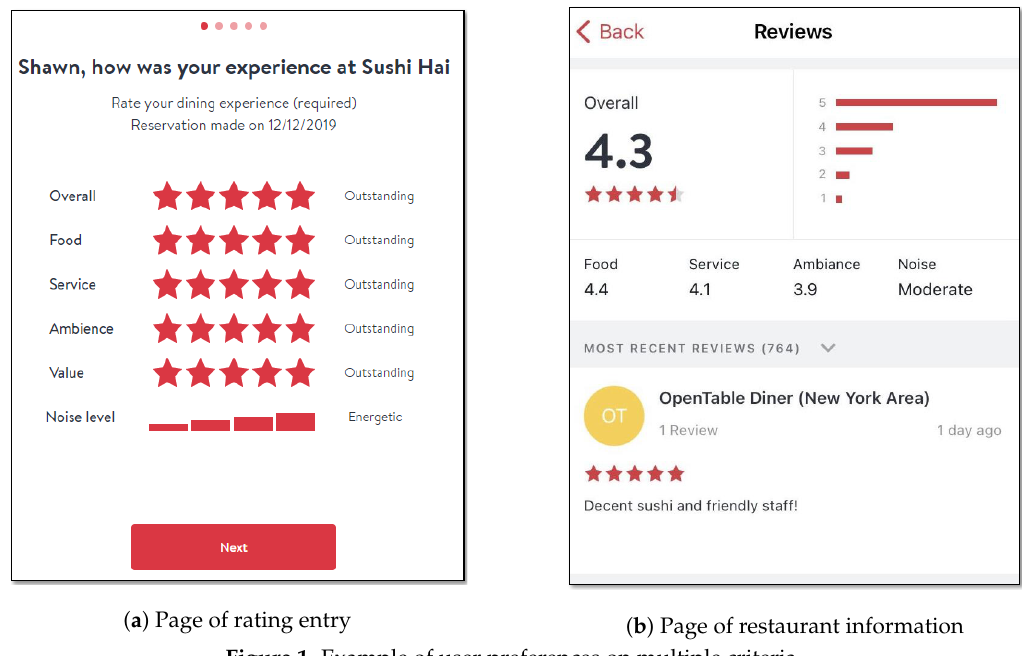
Figure 1. Example of user preferences on multiple criteria. Table 1. Example of Rating Matrix from